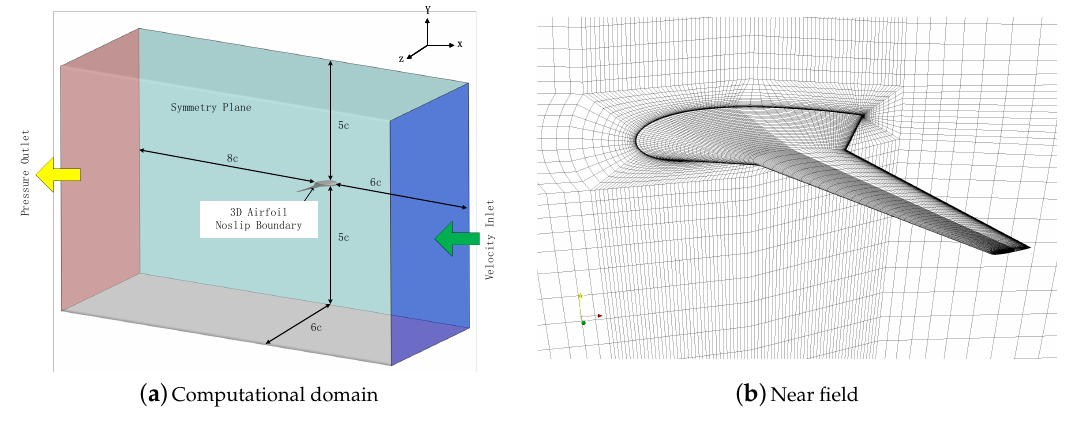
Figure 14. The computational domain and near mesh of 3D blended-wing-body airfoil.